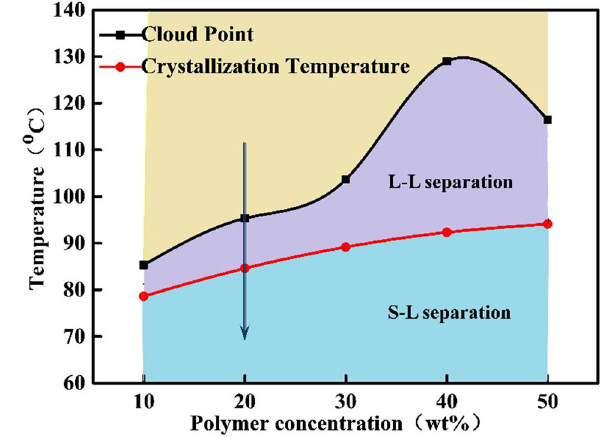
Fig. 2 Phase diagram of PVDF/[BMIM]BF4